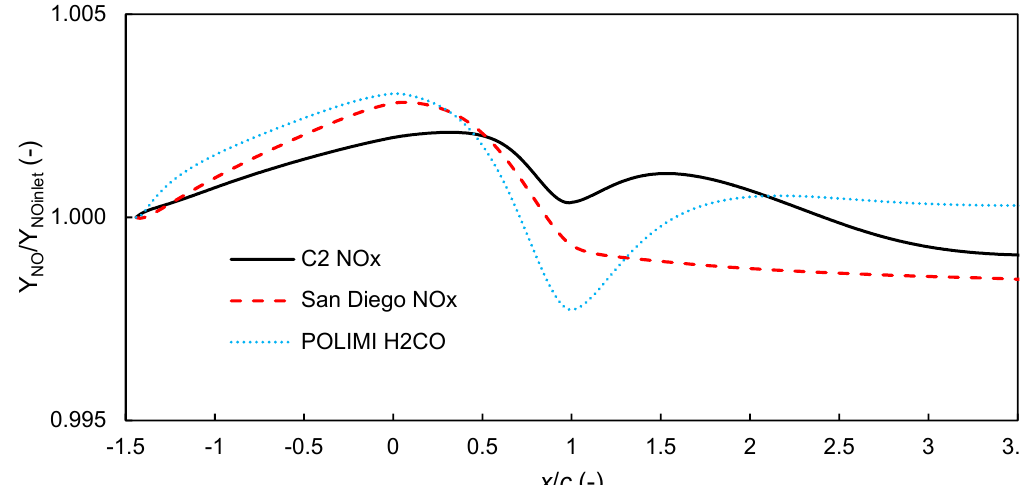
Figure 13. NO mass fractions for condition C (cruise, H 2 ) calculated utilising the CRN model with three different chemical reaction mechanisms.